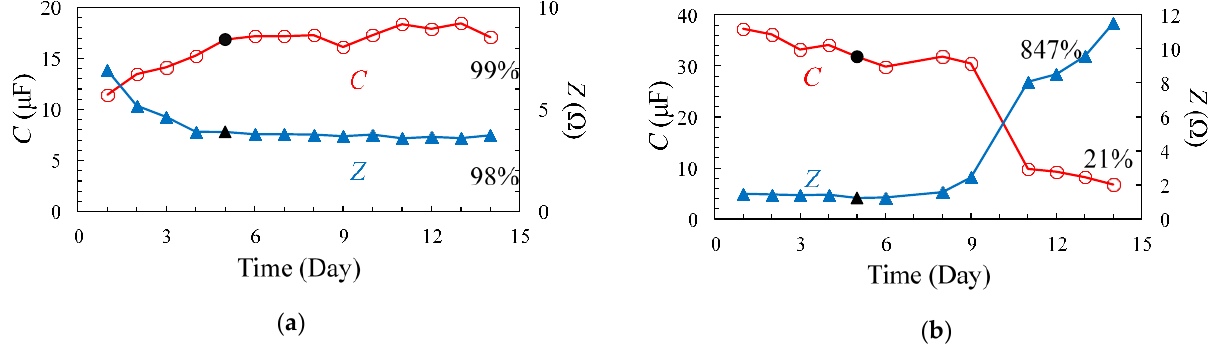
Figure 3. Results of ( a ) C and ( b ) Z measurements in the 80 °C degradation tests.